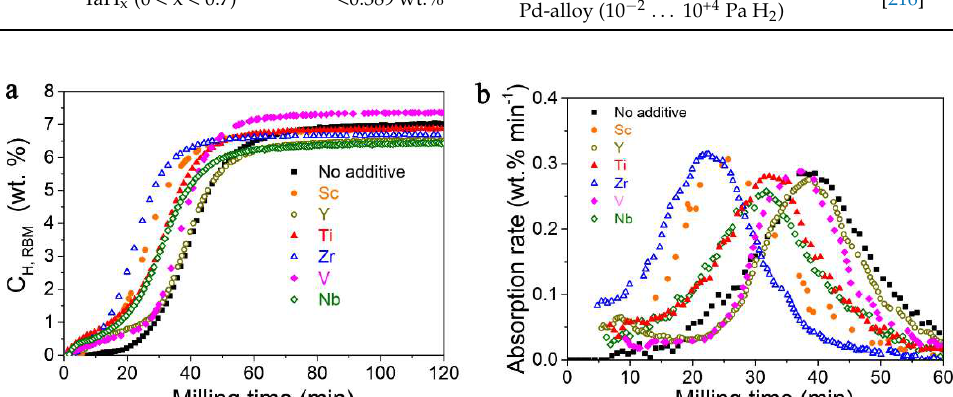
Figure 20. ( a ) Hydrogen uptake curves for 0.95 MgH 2 − 0.05 (ETM)H x during reactive ball milling; ( b ) absorption rate as derivative of hydrogen uptake curves. Reprinted/adapted with permission from Ref. [169]. 2019, Royal Society of Chemistry.